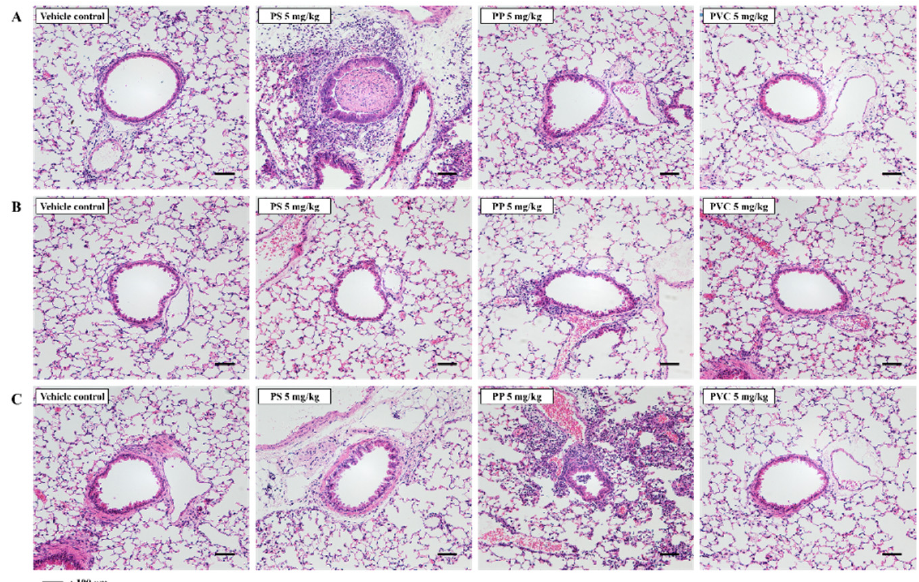
Figure 2. Representative H&E-stained lung tissue section of three strains of mice stimulated with